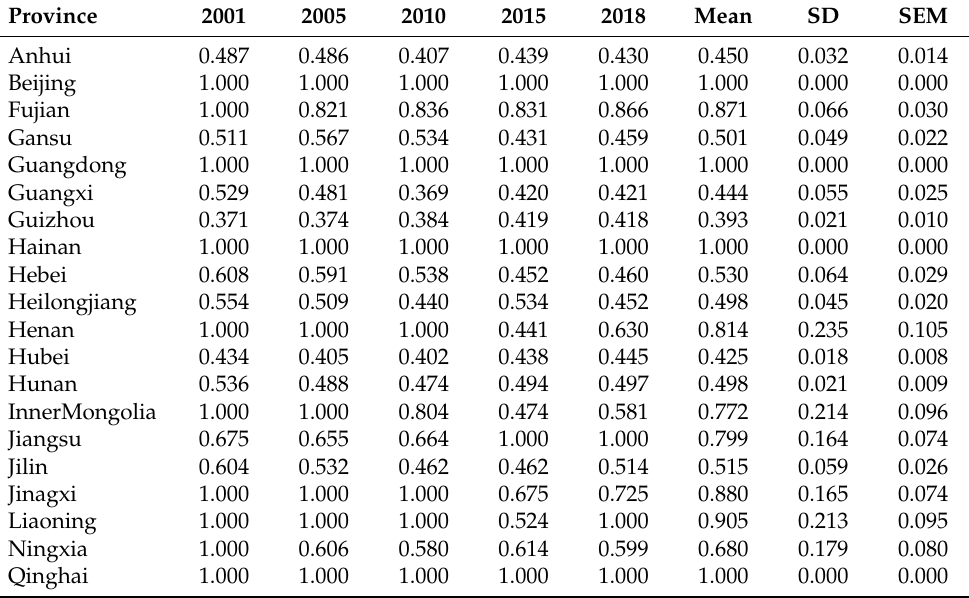
Table 3. PM2.5 Environmental efficiency scores for the 30 Chinese provinces in specific years.